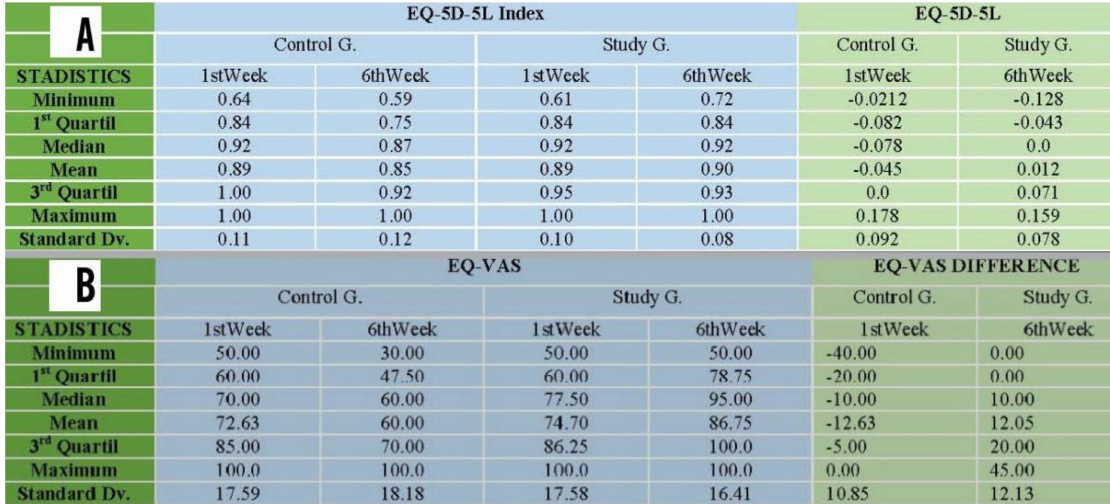
Figure 7. ( A ) Statistical description of the EQ-5D-5L Index and EQ-5D-5L Index differences for control and study groups. ( B ) Statistical description of EQ-VAS and EQ-VAS differences for control and study